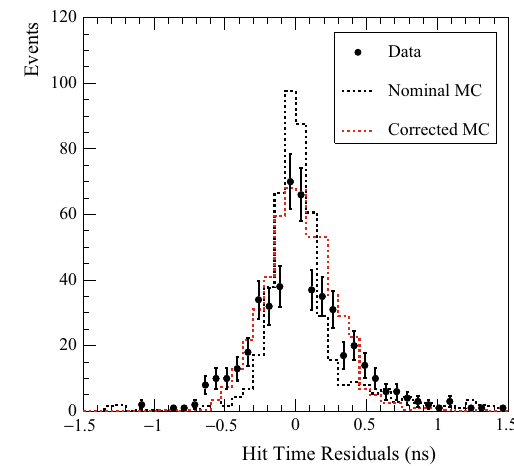
Fig. 4 Distribution of hit-time residuals with respect t reconstructed event time for ring candidate events in water for middle PMTs, where the Cherenkov ring is expected. Data points are shown with statistical errors, with the Monte Carlo prediction overlaid (dashed lines). Taken from [5]